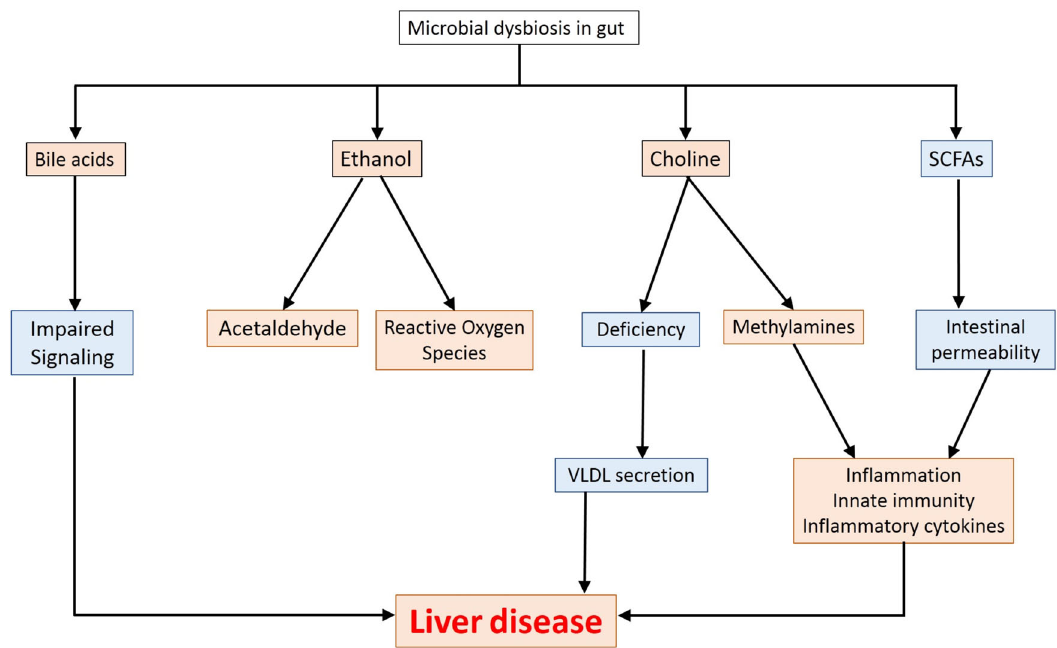
Fig. 2 Gut metabolites and liver disease. Metabolites biosynthesized by the microbiome and their impact on onset of liver